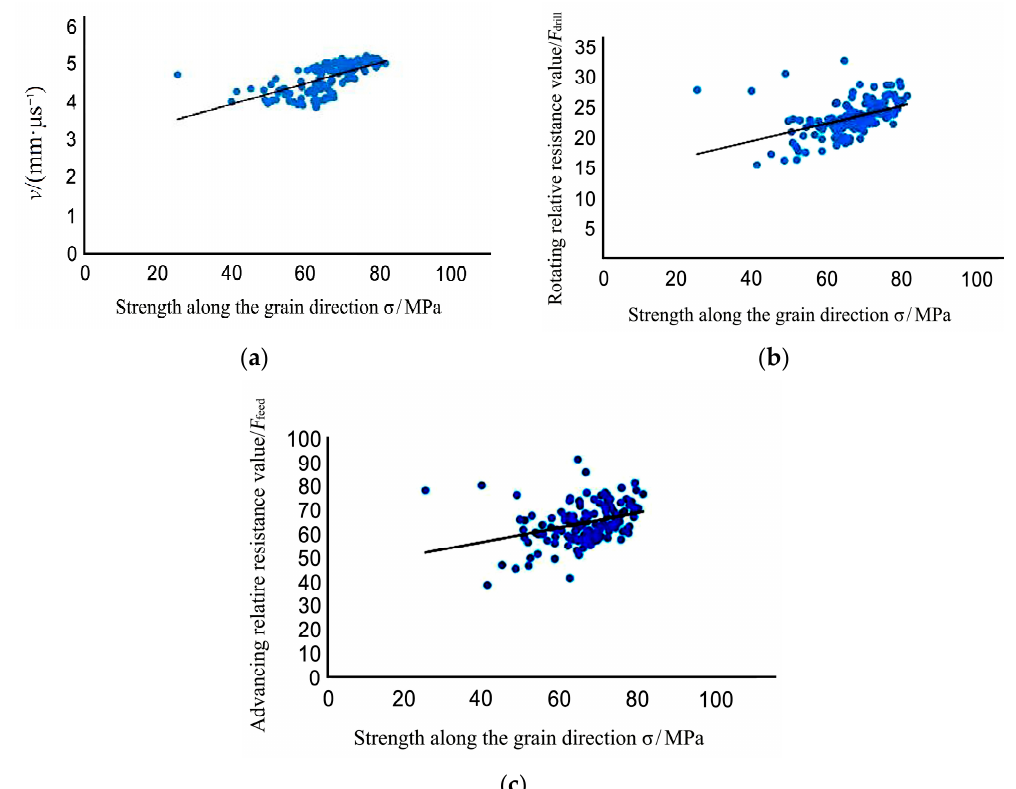
Figure 12. Relationship between nondestructive testing and compressive strength of small specimens: ( a ) Compressive strength and stress wave velocity; ( b ) Compressive strength and rotating relative resistance value; ( c ) Compressive strength and advancing relative resistance value.